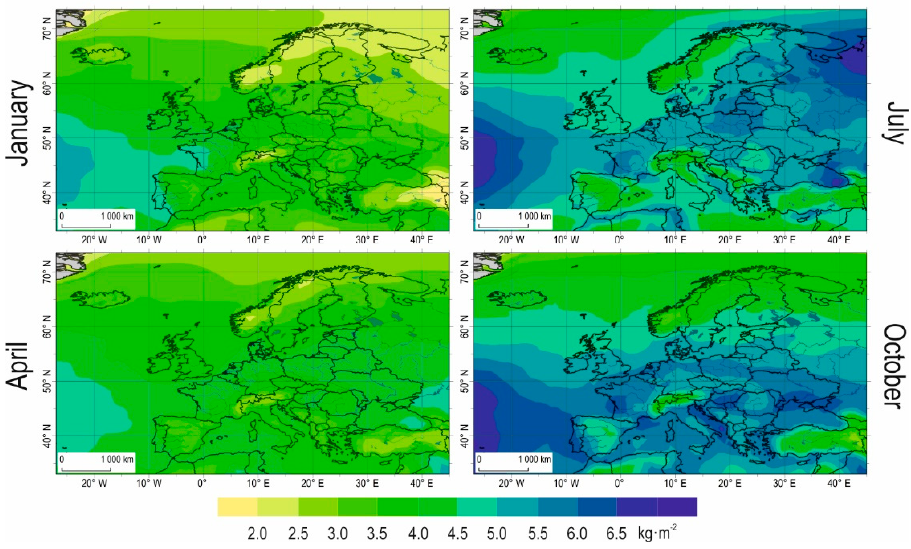
Figure 2. Standard deviations (SD) of monthly TCWV values (kg·m − 2 ) (1981–2015).